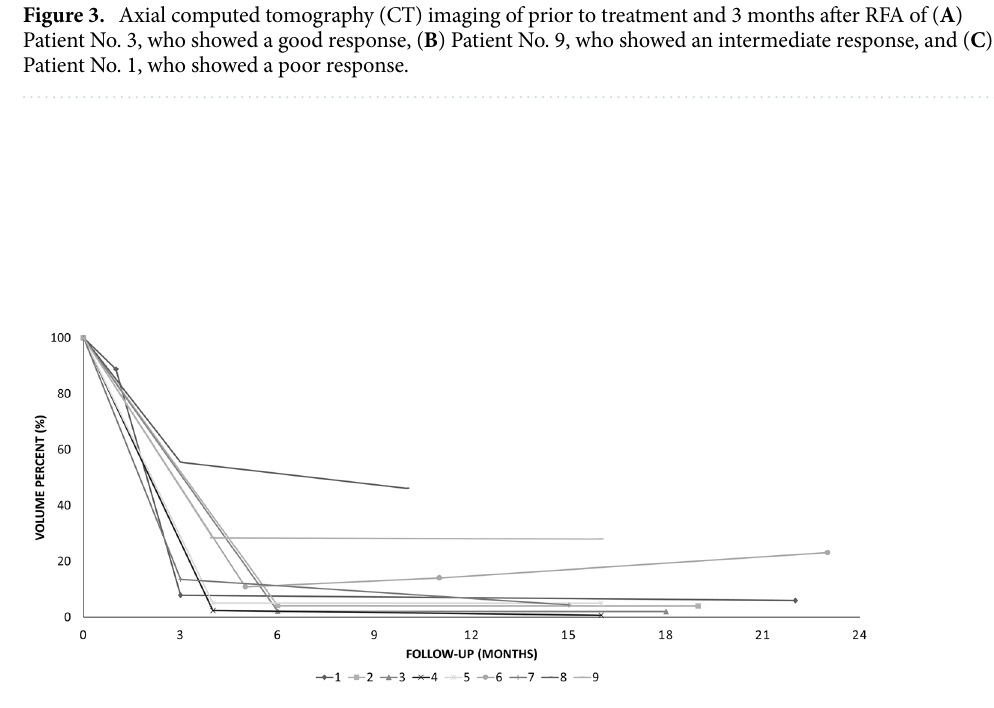
Figure 4. The volume change of cysts over